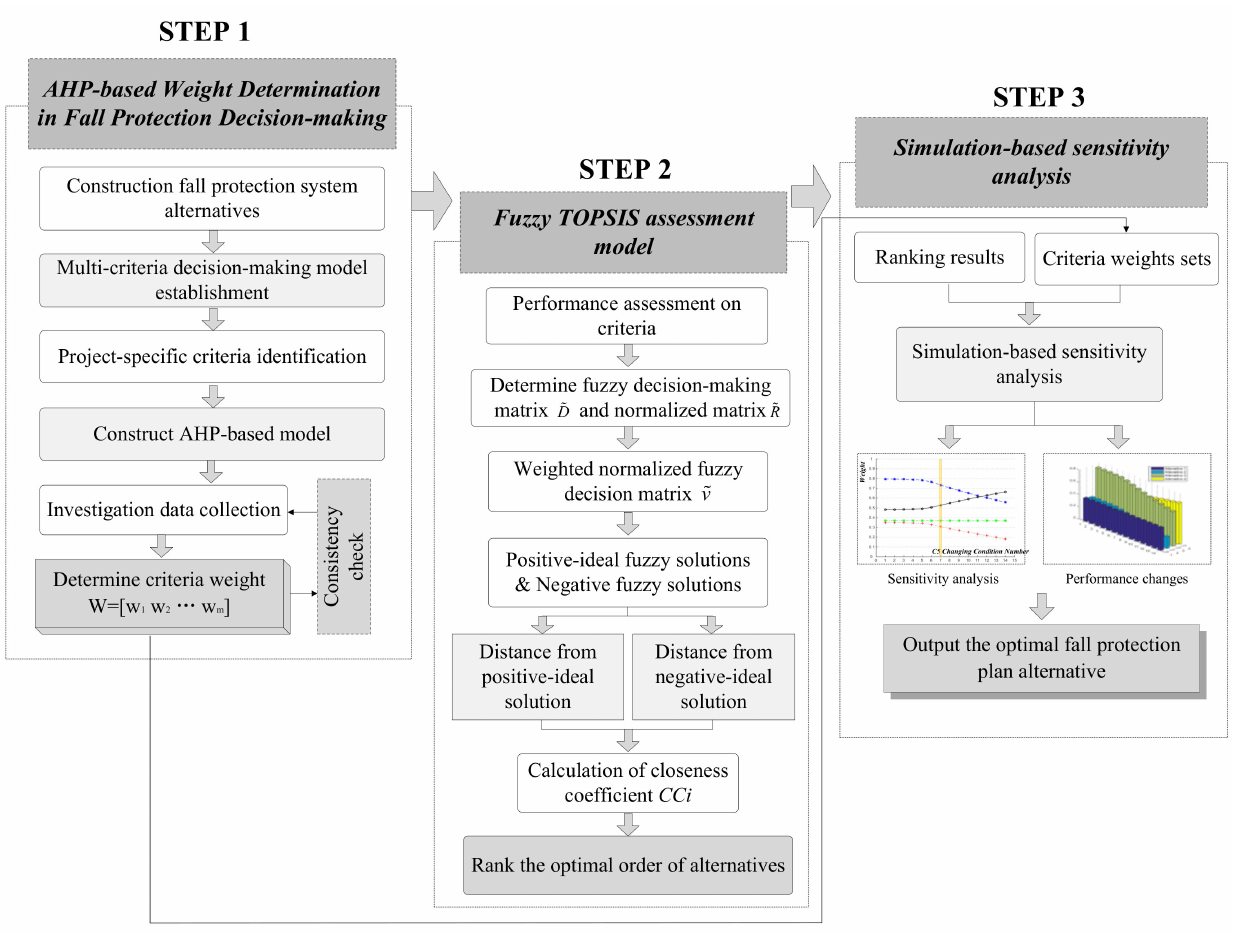
Figure 1. Research workflow of the safety performance assessment model